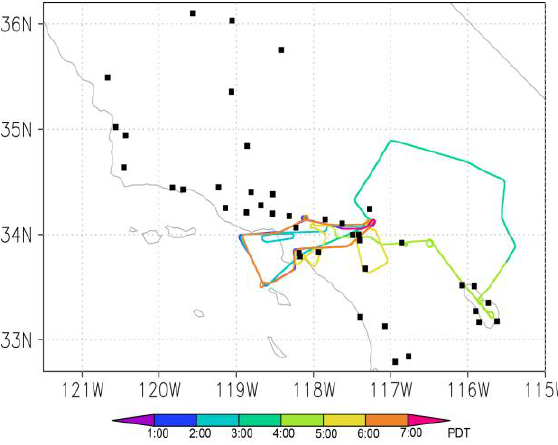
Figure 1 Map of the surface sites (black squares) and aircraft flight track on June 2, 2010 (colored curve)